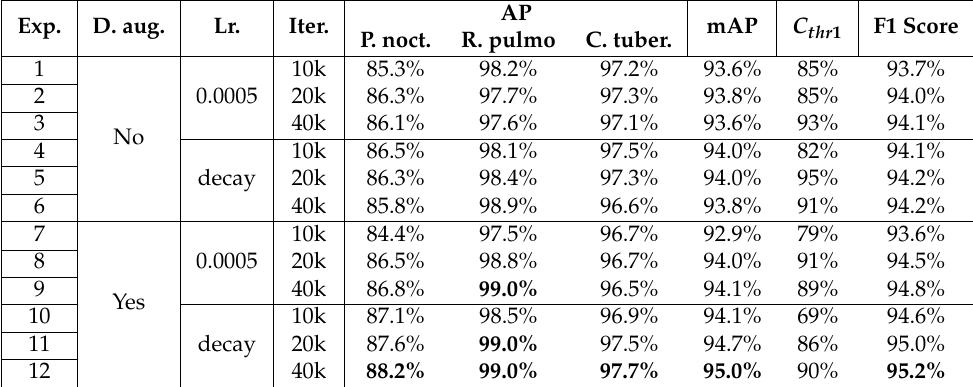
Table 2. Results obtained from the evaluation of each experiment K , indicating the hyperparameters used along with the AP obtained for each class, the mAP value, optimal C thr 1 and corresponding F1 score . Bold data indicates the highest score obtained for each metric. Exp. D. aug. Lr.